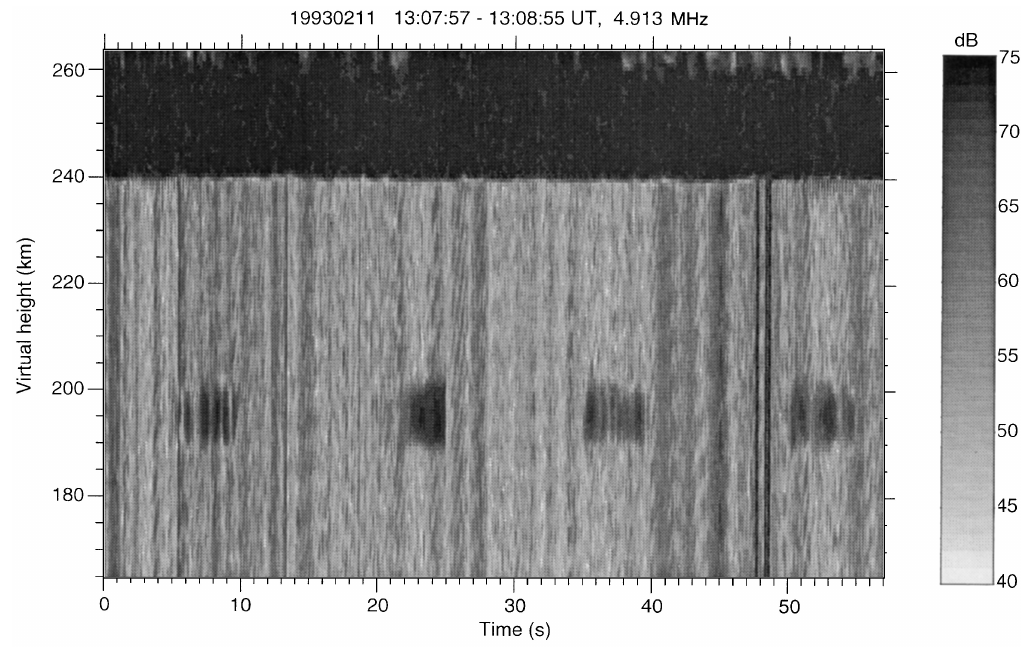
duration every 15 s. The vertical resolution is 9 km, determined by the 60 (cid:108) s pulse length and the 30-kHz receiving bandwidth. The dark band above 240 km is the saturated echo from the F